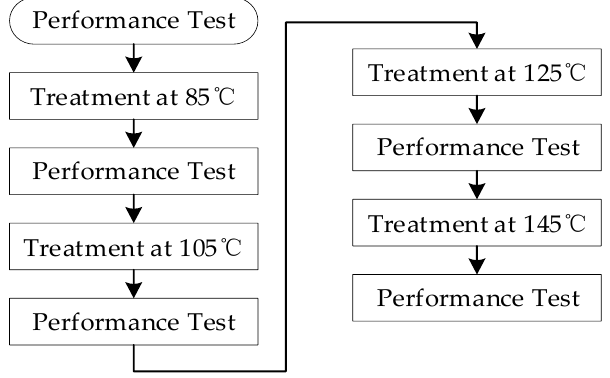
Figure 8. The process of the temperature tolerance experiment.